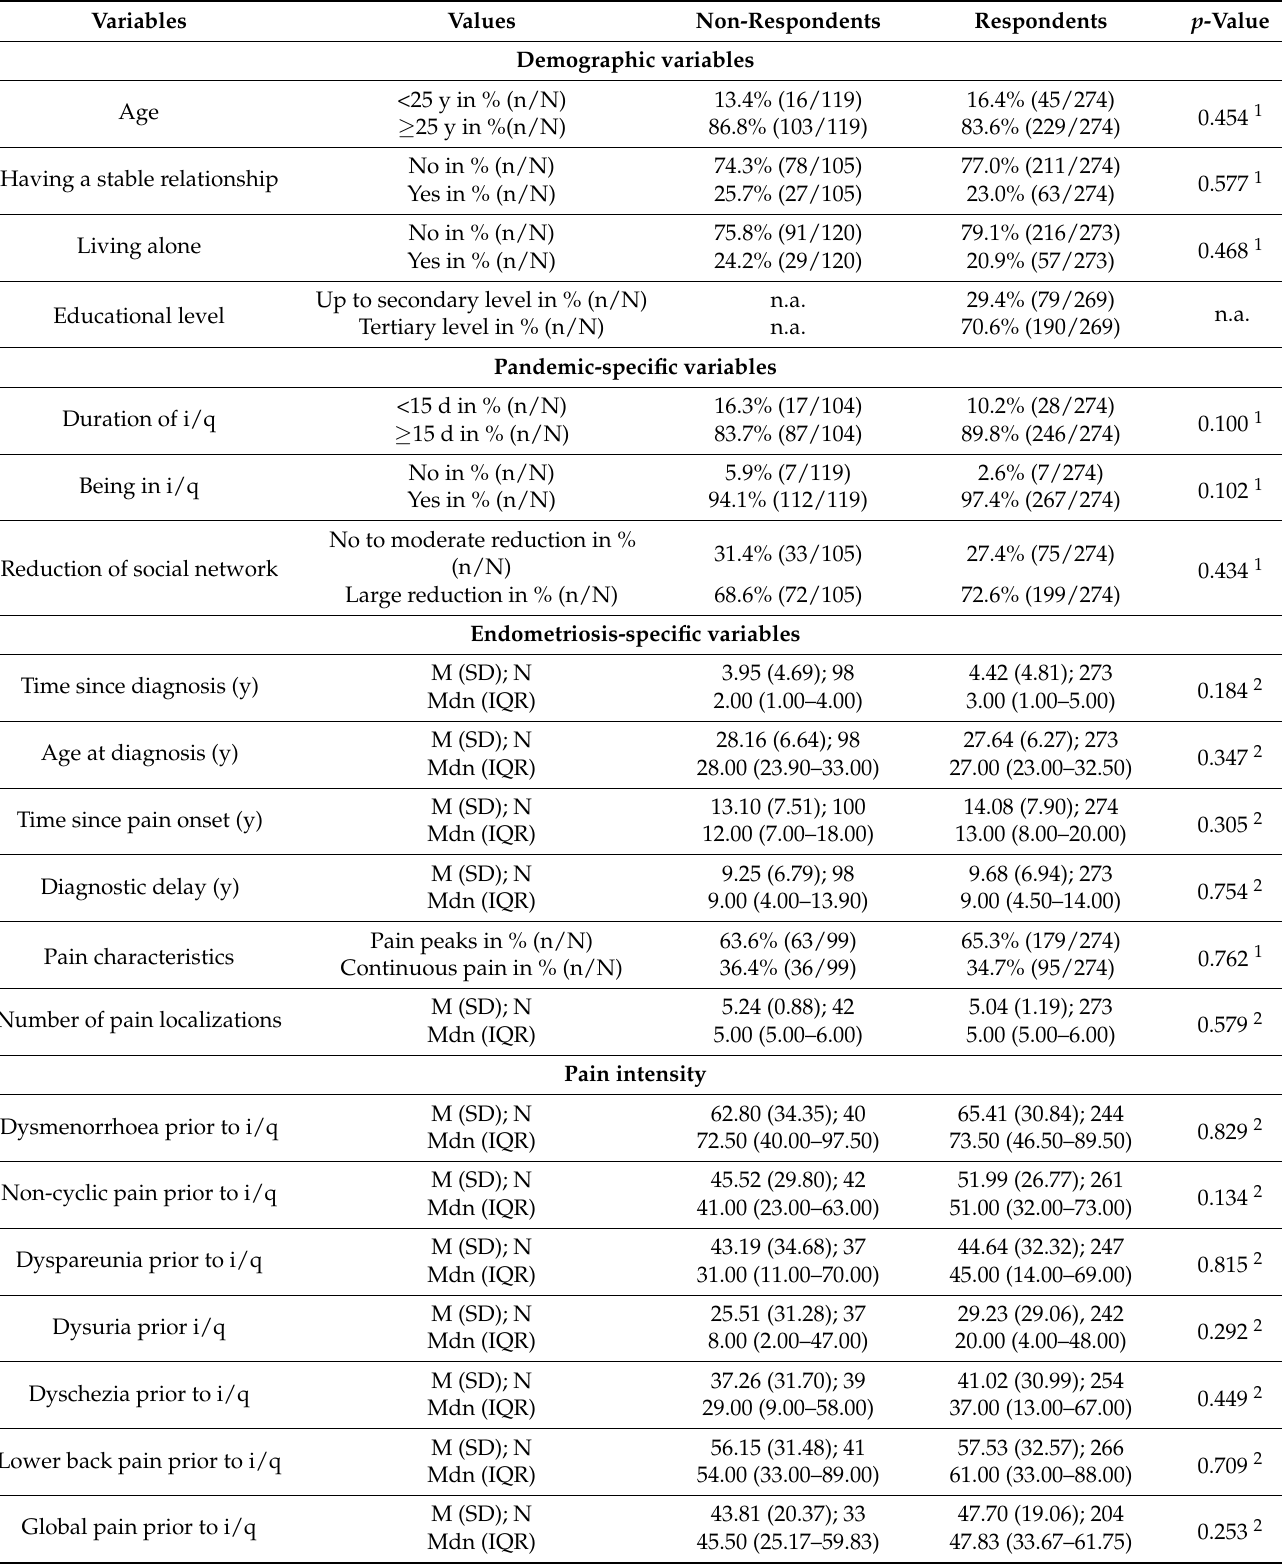
Table 1. Differences between participants who did not complete the PHQ-4 questionnaire (group “Non-respondents”) versus those who completed at least one of the questions (group